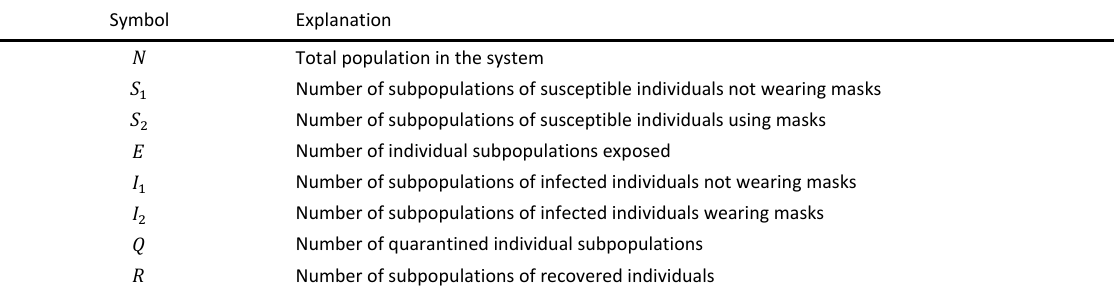
Table 1: COVID-19 spread model variable symbol